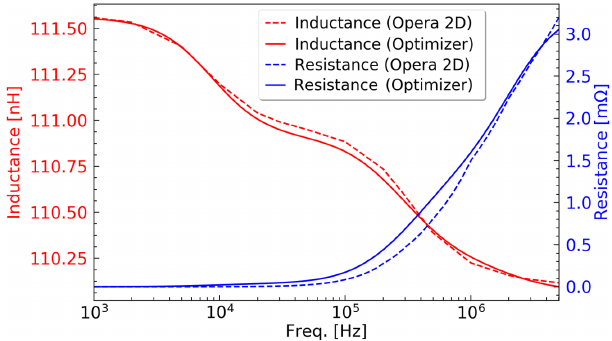
FIG. 15. Frequency dependent inductance and resistance of the FCC-hh injection kicker magnet with a beam screen composed of 24 Cu screen conductors ( 30 μ m × 1 . 3 mm). Opera-2D data is compared with the fit of the equivalent circuit obtained using PSpice and the PSpice